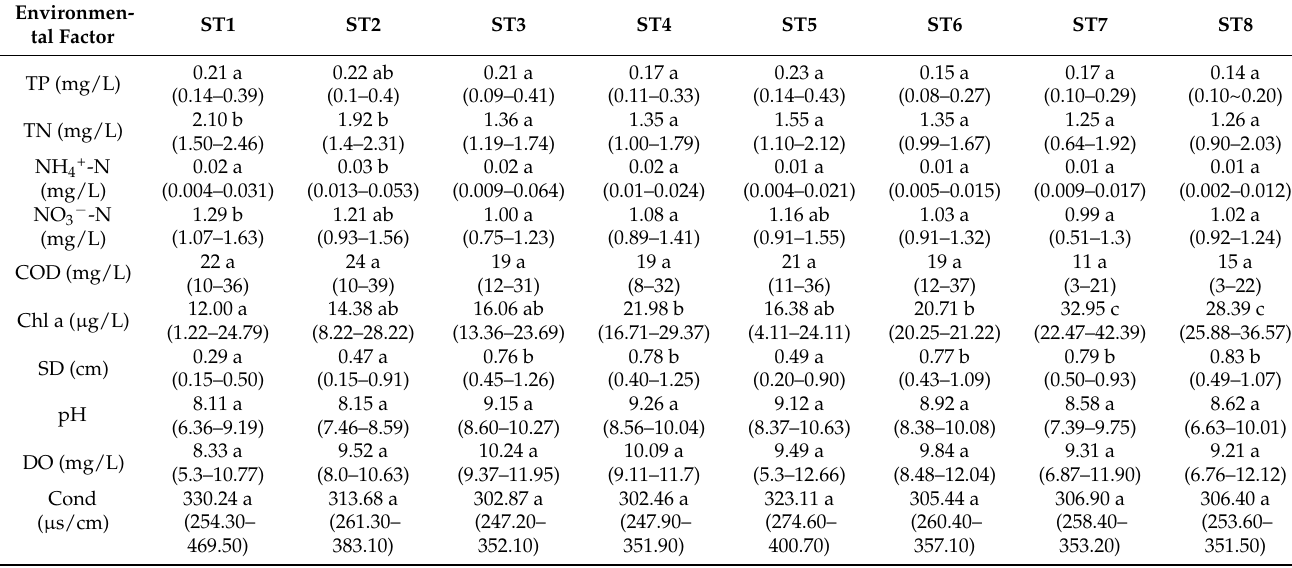
Table 1. The average values and ranges of physical and chemical factors of Qingcaosha Reservoir in 2019. Environmen- tal